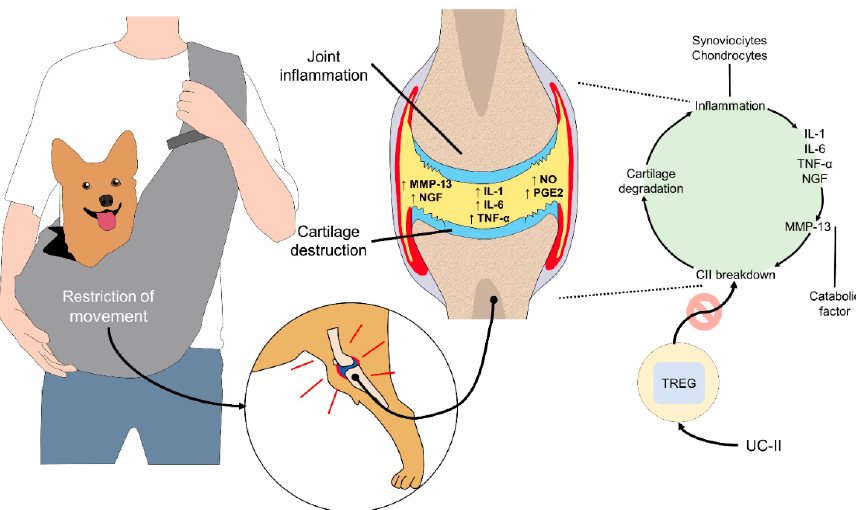
Figure 5. Osteoarthritis mechanism due to restricted movement in companion animals. When a dog or cat is unable to move voluntarily for a long period, cartilage degradation takes place as a result of an inflammatory process in the joints. Synoviocytes and chondrocytes secrete pro-inflammatory substances (IL-1, IL-6, TNF- α ), neuropeptides (NGF), mediators (NO and PGE2), and MMPs. Individually, MMP-13 is a catabolic factor that breaks down the CII with the consequent cartilage degradation and loss. This pathophysiology of cartilage damage induces a degenerative joint disease cycle with persistent inflammation in animals. UC-II is a novel pharmacologic alternative that uses immune cells, (TREGs) to block the pro-inflammatory effects. After TREGs recognize the presence of UC-II, these cells secrete anti-inflammatory mediators and promote cartilage repair. CII: collagen type II; IL: interleukin; MMP-13: metalloproteinase 13; NGR: nerve growth factor; NO: nitric oxide; PGE2: prostaglandin E2; TNF- α : tumor necrosis factor alpha; TREG: regulatory T cells; UC-II: undenatured type II